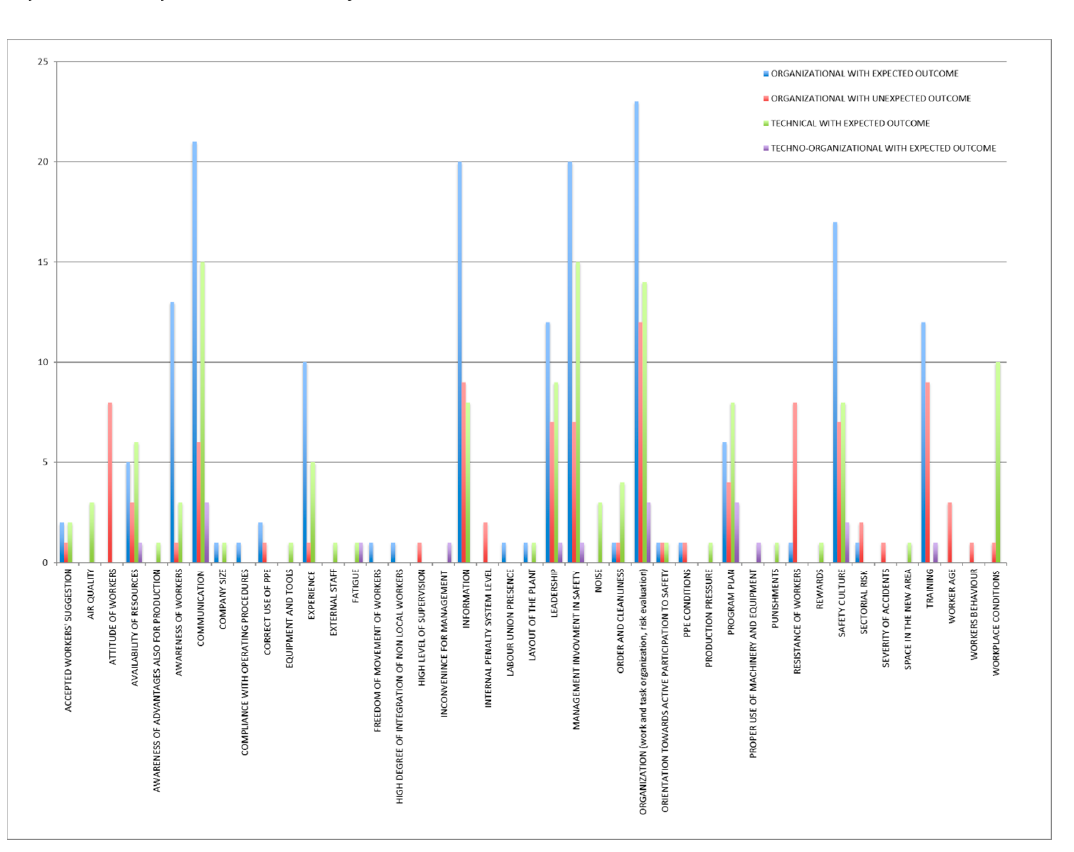
Figure 12. Comparison of contextual factors (in terms of number of occurrences).